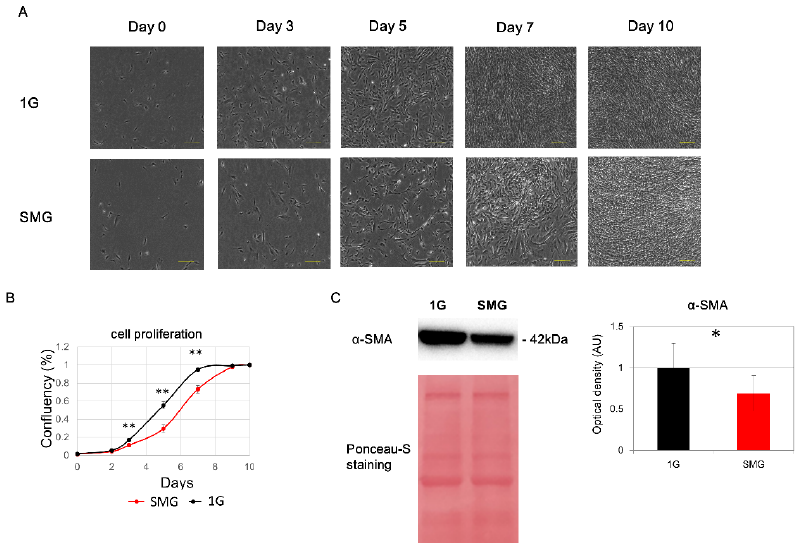
Figure 1. Evaluation of HHSteC proliferation under simulated microgravity (SMG). ( A ) Micrograph of cells under SMG ( n = 6). ( B ) Evaluation of proliferation under SMG. Red line: SMG; black line: 1 G. ( C ) Western blotting analysis of α -SMA ( α -smooth muscle actin), a stellate cell activation marker, and Ponceau-S staining as a loading control. The quantified bands were normalized to Ponceau (total protein) ( n = 6). Statistical analysis was performed with Student’s t -test; * indicates p < 0.05, and ** indicates p < 0.01.